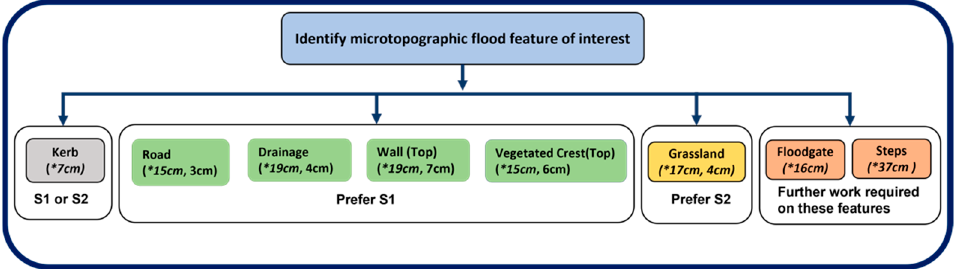
Figure 11. Survey decision framework for S1 (UAS–RGB) and S2 (aircraft–LiDAR) for the characterization of microtopographic features. Values in brackets show the (*) median elevation difference between S1 and S2 and the elevation accuracy.